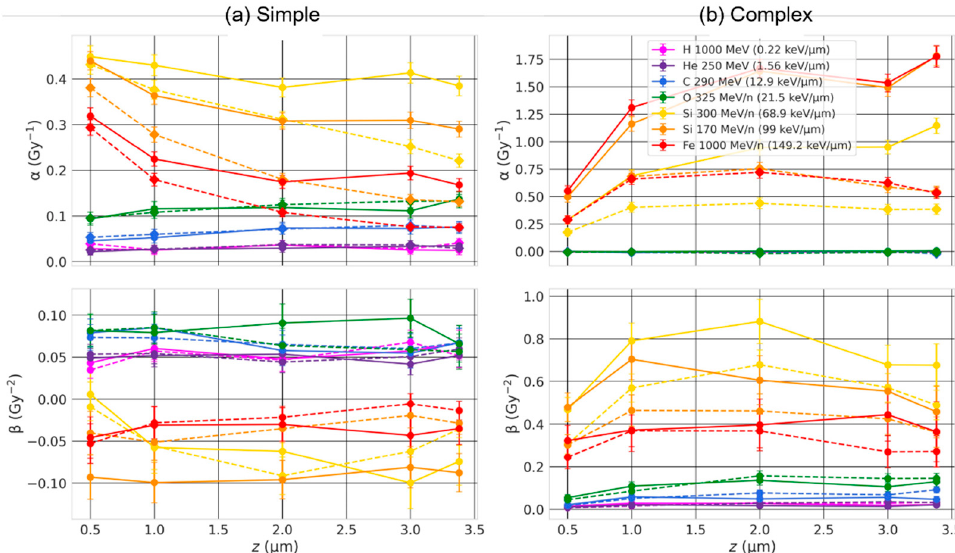
Figure 7. 𝛼 and 𝛽 coefficients of simple ( a ) and complex ( b ) exchanges as a function of the cell thickness, for AG1522 cell line (V = 162 μ m 3 ), and for ion beams of varying LET. Straight lines were added between RITCARD datapoints to help visualization. Solid line with round symbols: without chromosome domain constraint. Dashed line with diamond symbols: with chromosome domain constraint.